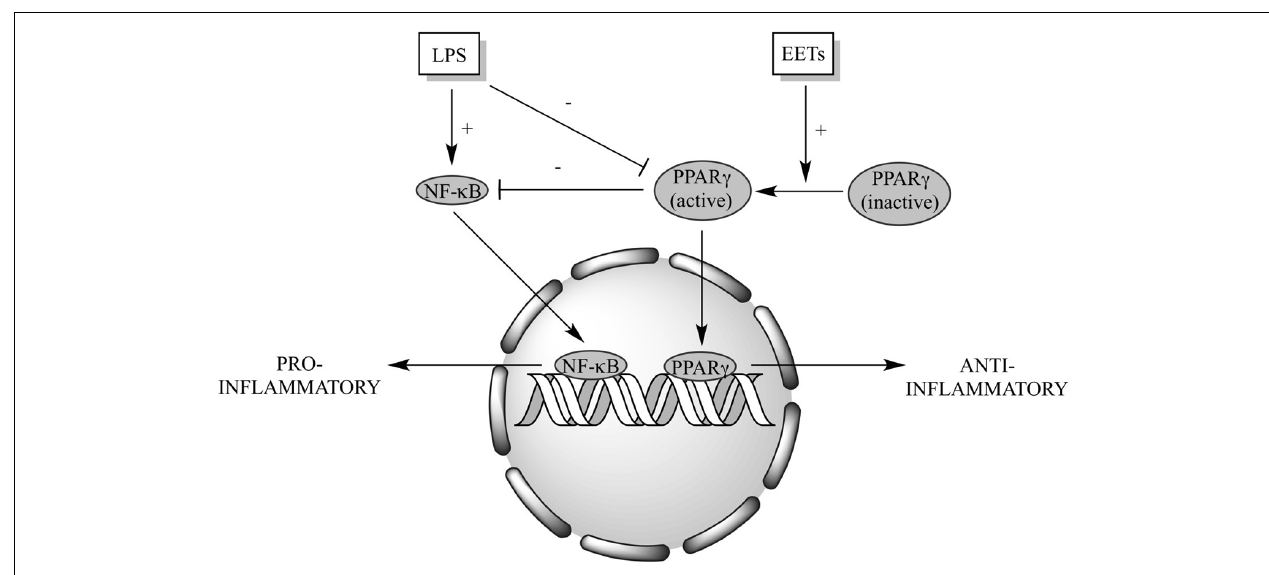
FIGURE 7 | Schematic of proposed EET cardioprotective mechanism(s). LPS triggers activation of NF- κ B-dependent signaling and suppresses PPAR γ activation, resulting in a shift of the cellular response to a pro-inflammatory